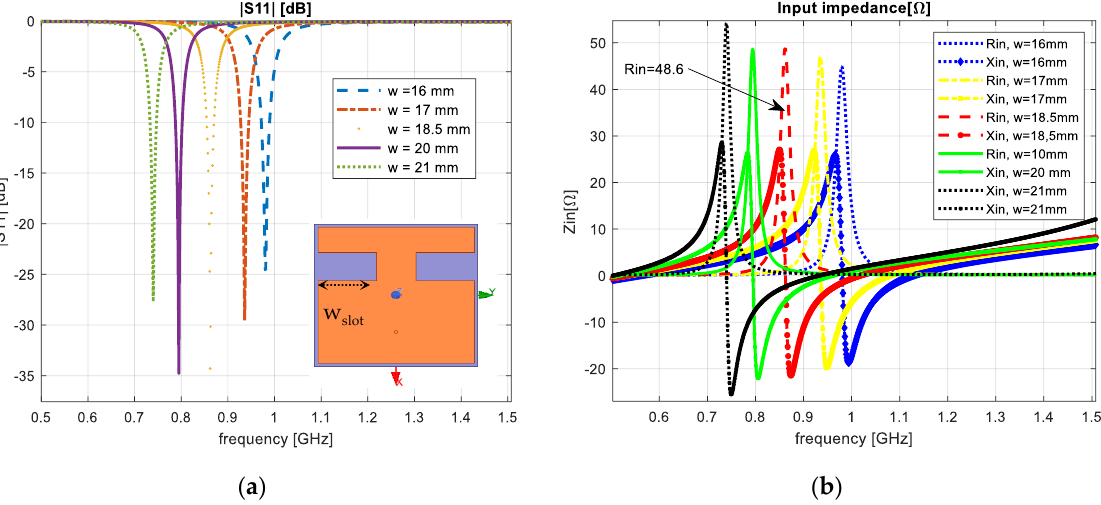
Figure 3. Varying the notches ’ width: ( a ) reflection coefficient; ( b ) input impedance.